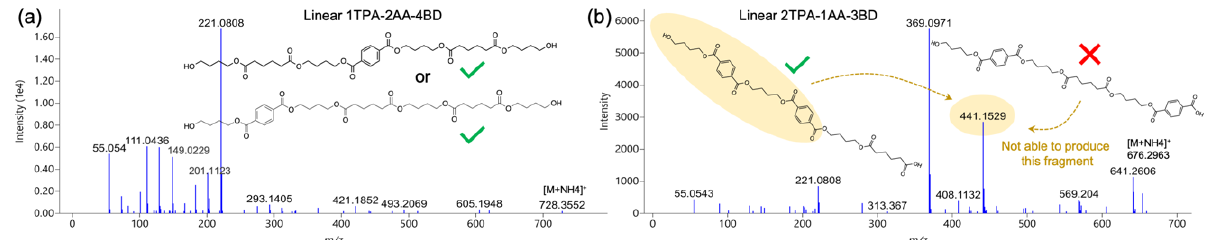
Figure 4. Discrimination of isomers of PBAT oligomers by MS/MS spectrum: ( a ) two isomers of Linear 1TPA-2AA-4BD not discriminated; ( b ) isomers of Linear 2TPA-1AA-3BD differentiated by a characteristic product ion (441.1529).